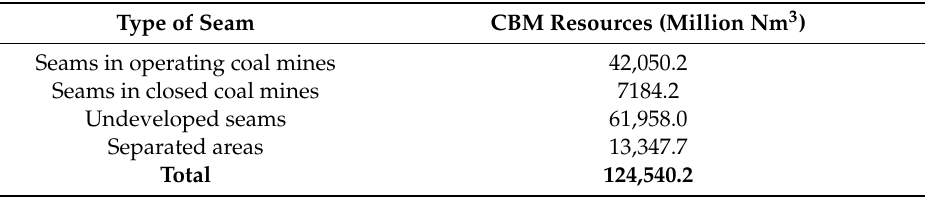
Table 2. Estimated recoverable CBM resources within the boundaries of the selected